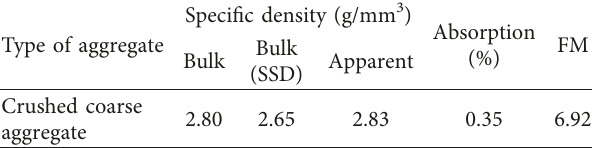
Table 3: Physical properties of coarse